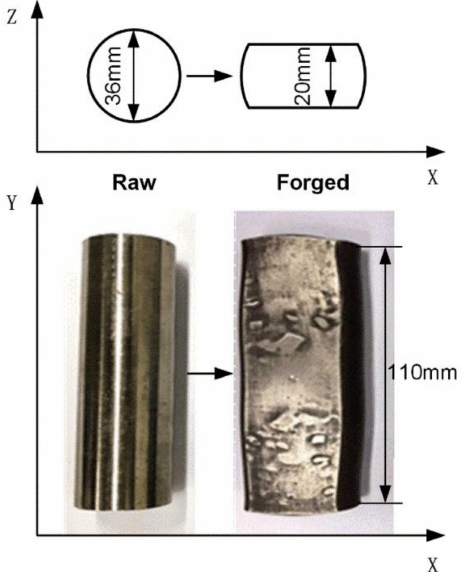
Figure 2. Specimen shapes before and after